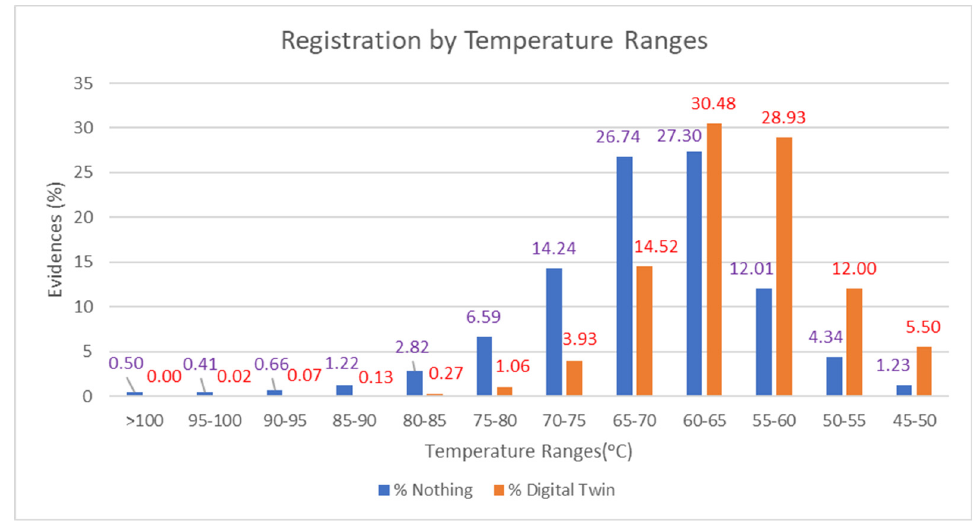
Figure 9. Graph showing the number of registers recorded when using the digital twin or the previous system available at the foundry.